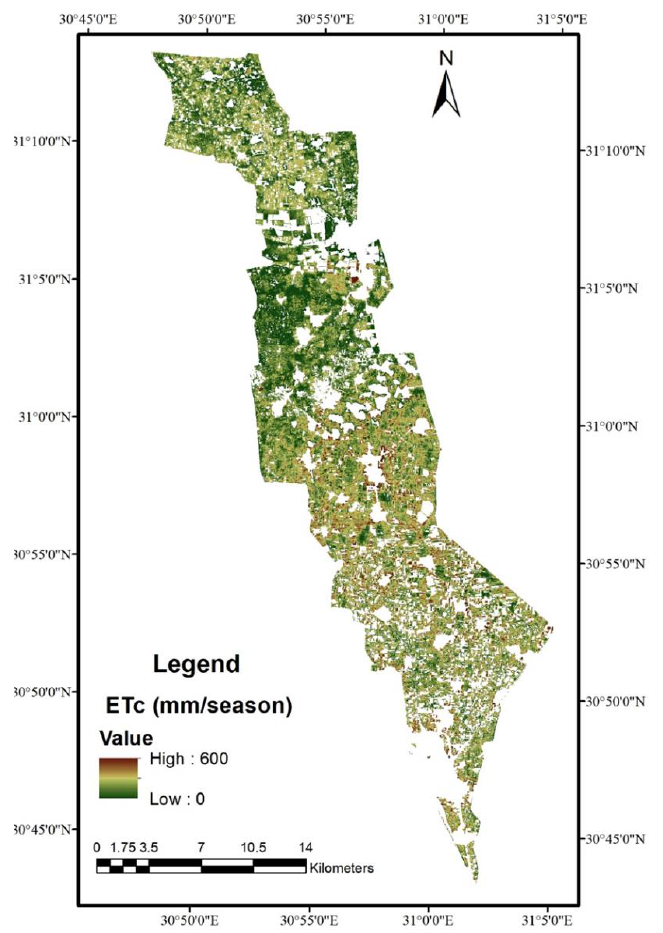
Figure 4. Actual evapotranspiration ( ET c ) of the study area during the winter (from November 2015 to May 2016).